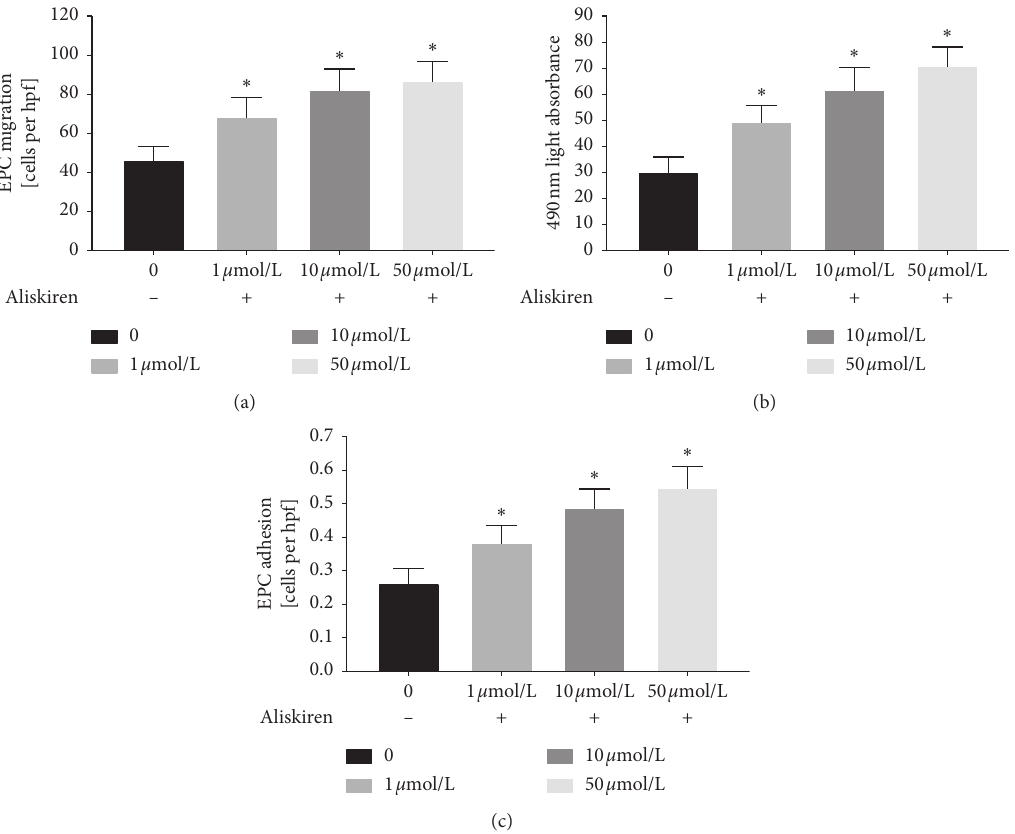
Figure 3: The effect of different concentrations of aliskiren on the in vitro function of patients’ EPCs. (a) Quantification analysis of the migration of patients’ EPCs treated with 1 μ mol/L, 10 μ mol/L, or 50 μ mol/L aliskiren for 12h ( ∗ P < 0 . 05 vs. subjects’ EPCs without aliskiren treatment, n � 18 per group). Quantification analysis of the proliferation (b) and adhesion (c) of patients’ EPCs treated as described above ( ∗ P < 0 . 05 vs. subjects’ EPCs without aliskiren treatment, n � 18 per group). hpf � high-power